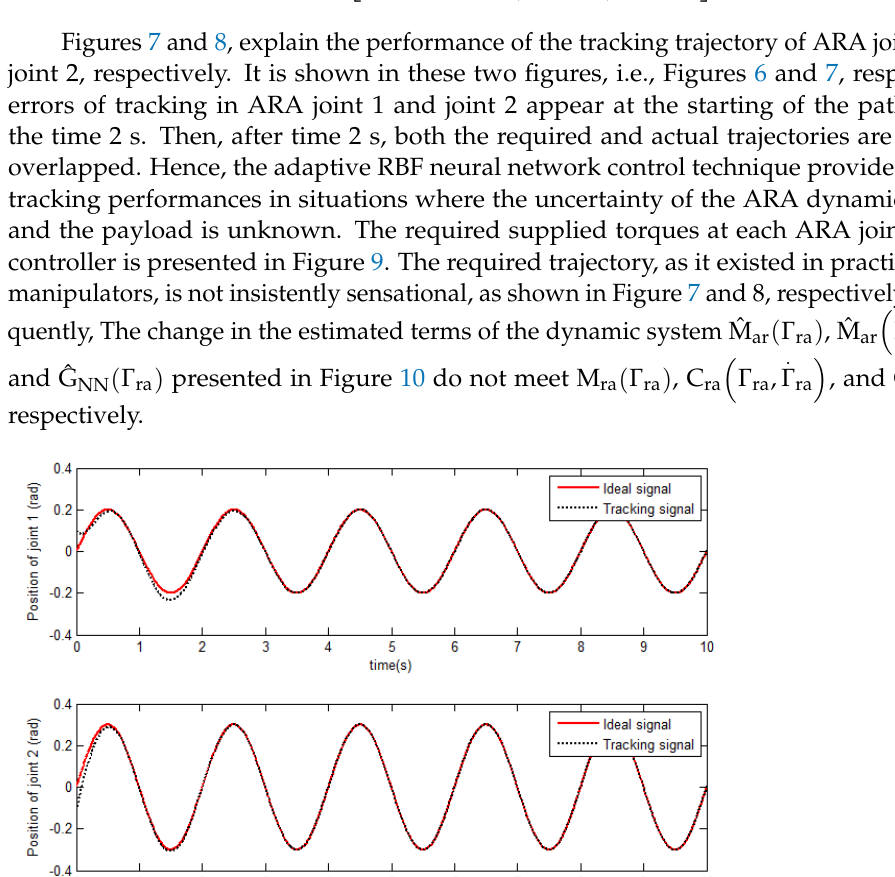
Figure 8. Speed of ARA joint 1 and joint 2.